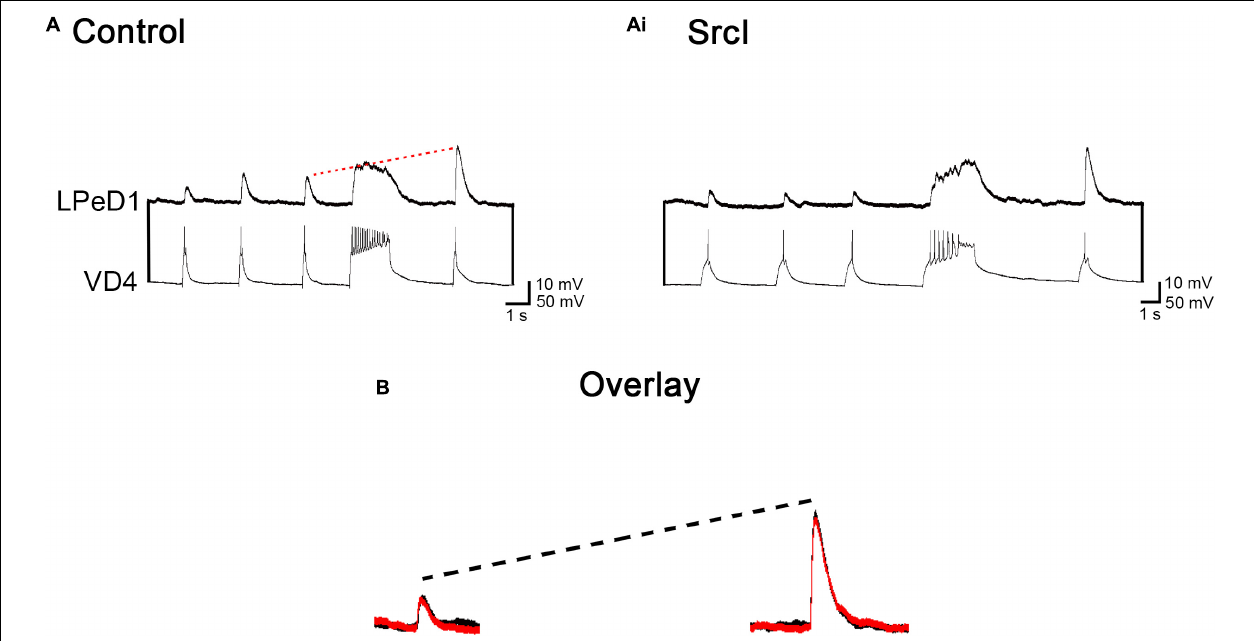
FIGURE 3 | Treatment of visceral dorsal 4 (VD4)–left pedal dorsal 1 (LPeD1) soma–soma pairs with SrcI does not affect synaptic transmission or short-term potentiation (STP). (A) VD4–LPeD1 pairs were cultured in a soma–soma configuration overnight in conditioned media (CM). Both cells were impaled with intracellular electrodes the next day, to confirm that excitatory synapses had formed. Pre- and post-tetanus EPSP amplitudes were measured in LPeD1 (held at –100 mV for consistency). The red dotted line illustrates that post-tetanus EPSPs were potentiated, on average, by 207%, compared to their pretetanus counterparts ( n = 16). (Ai) Following control recordings, VD4–LPeD1 pairs were incubated in 5 µ M Src for 1–1.5 h. Pre- and post-tetanus EPSP amplitudes were then measured in LPeD1. Post-tetanus EPSPs were potentiated, on average, by 175% ( n = 16). (B) Overlay of pretetanus EPSPs (left) and potentiated post-tetanus EPSPs (right) in control and SrcI-treated cell pairs. Black = control. Red = SrcI. Neither synaptic transmission ( p = 0.275) nor STP ( p = 0.086) were affected by treatment with SrcI, as determined using a paired samples t -test ( n =